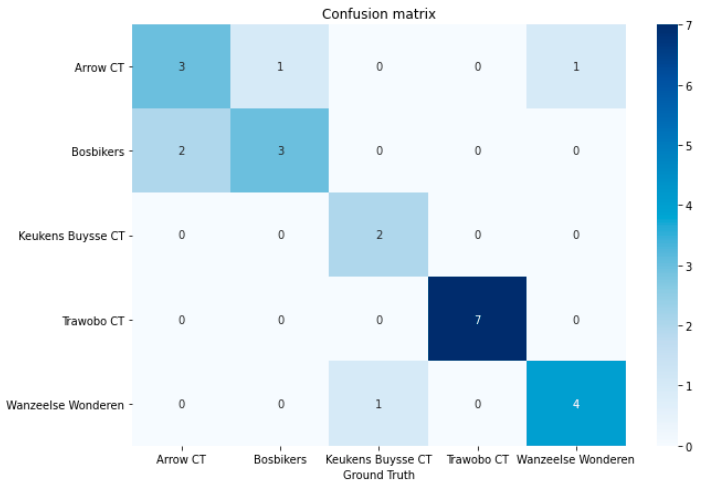
Figure 9. Confusion matrix of team predictions on unseen validation images trained on five team jersey classes.